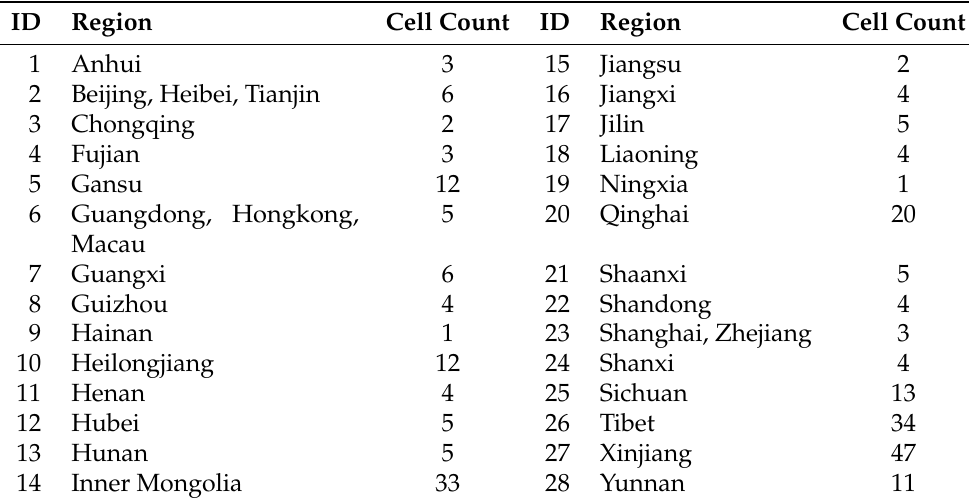
Table 1. Arrangement of 28 Chinese regional divisions in cellular